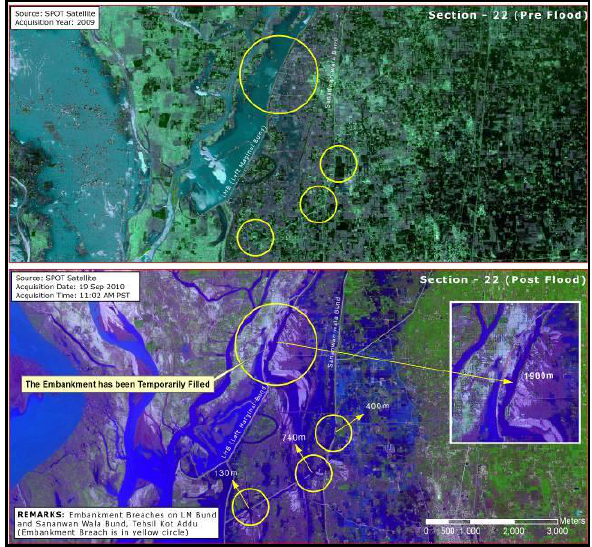
Figure 2. LMB Breach near Taunsa Barrage, Punjab